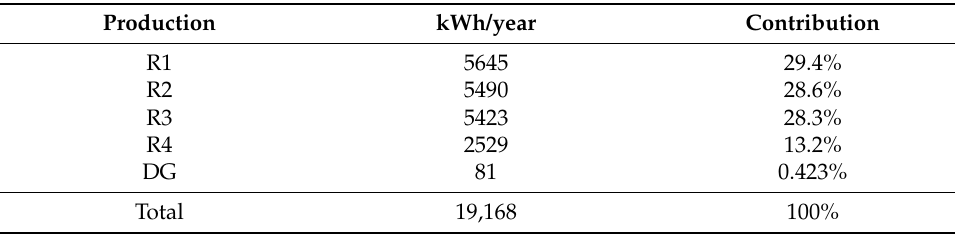
Table 10. Summary of energy production of the OSC at 22 kWh/day.